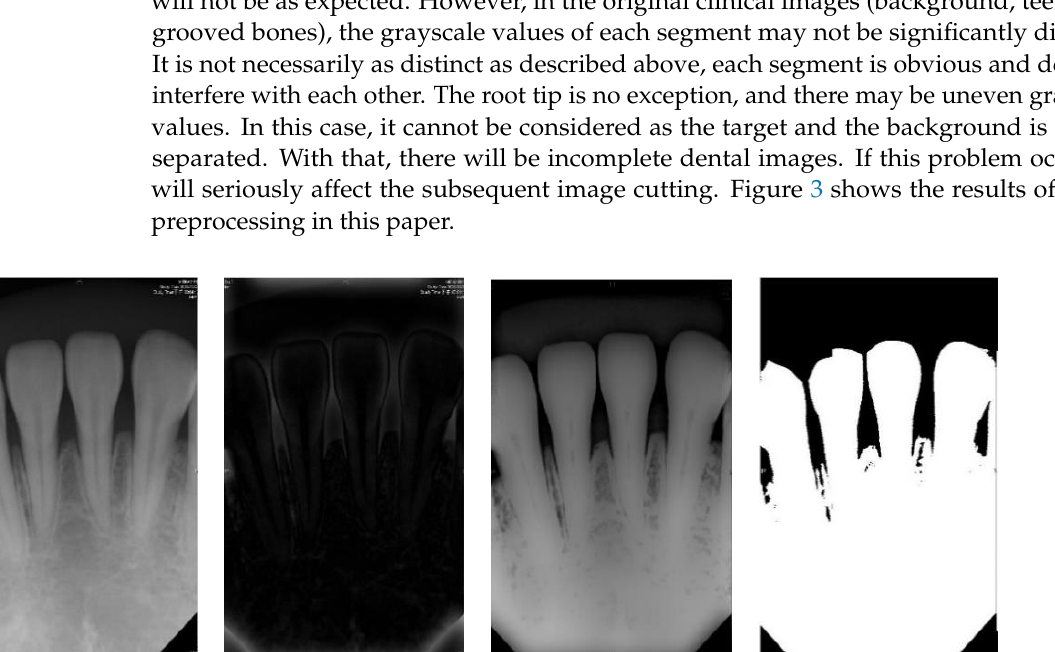
Figure 2. Proposal flowchart.